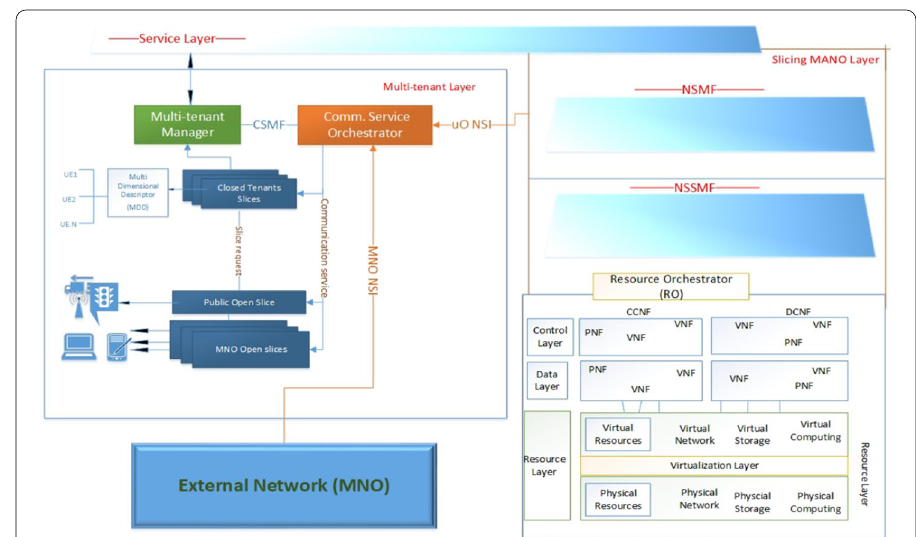
Fig. 9 Micro‑operator slicing architecture with focus on the multi‑tenant layer [11]. The figure present an extended version of the micro‑operator slicing architecture based on Fig. 6 with focus on the multi‑tenant